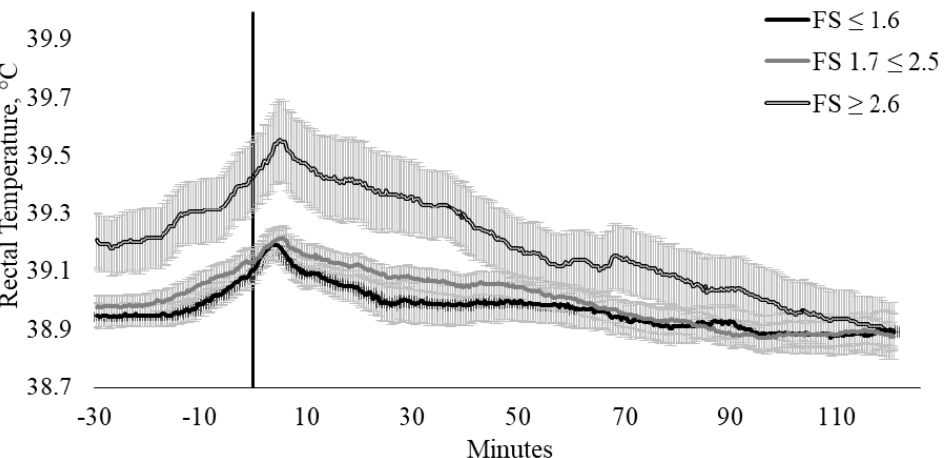
Figure 5. Twenty-seconds mean (±SEM) rectal temperature (T REC , °C) of cattle with flight speeds of ≤ 1.6 m / s (FS ≤ 1.6; n =